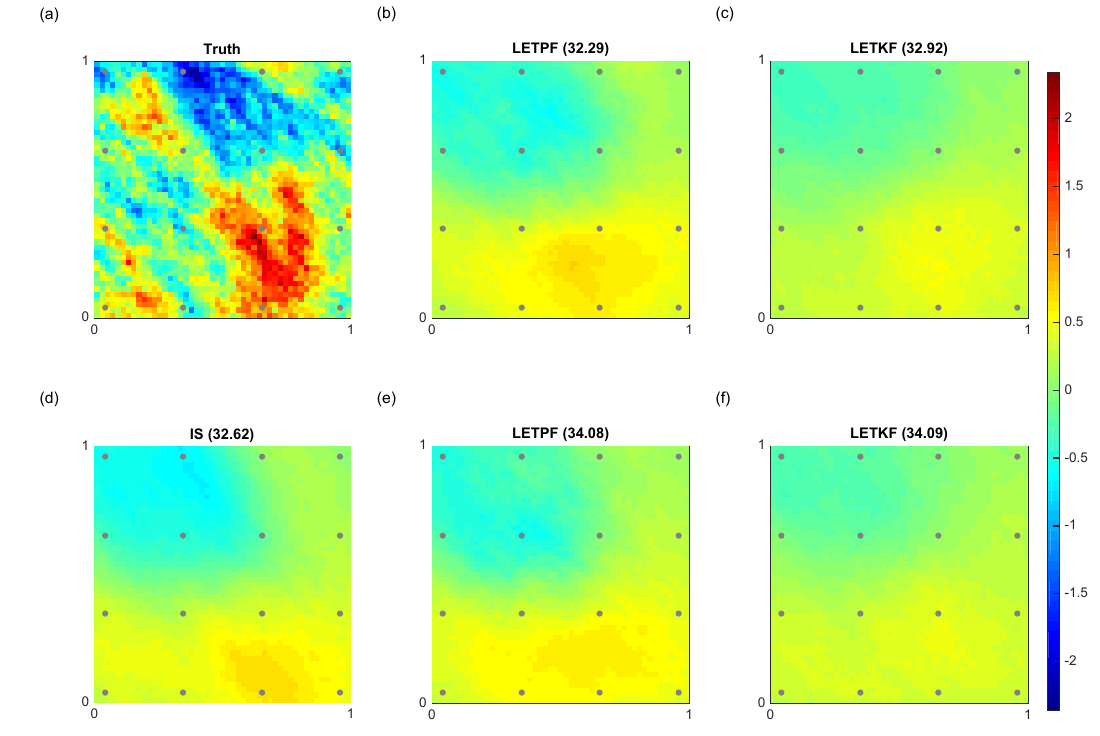
Figure 15. Same as Fig. 8 but with